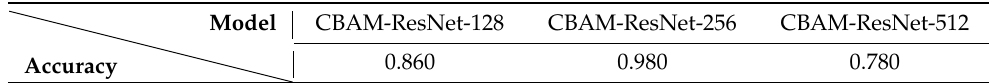
Table 2. The results of the three networks of the CBAM-ResNet model.